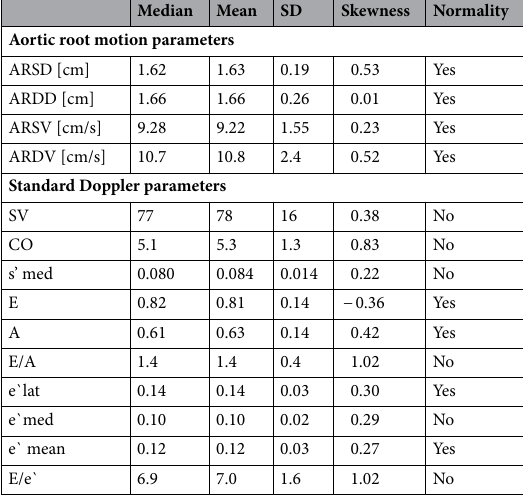
r ( p value) ARSD ARDD